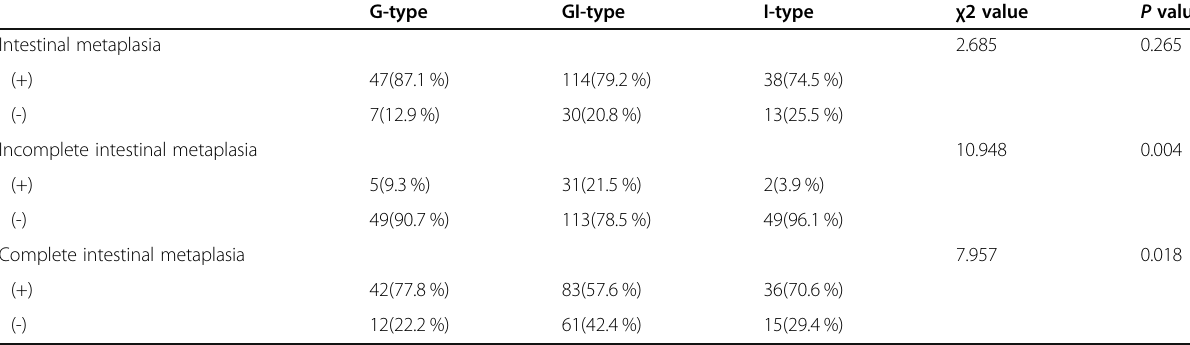
Table 2 Relationship between mucin phenotypes and background mucosa